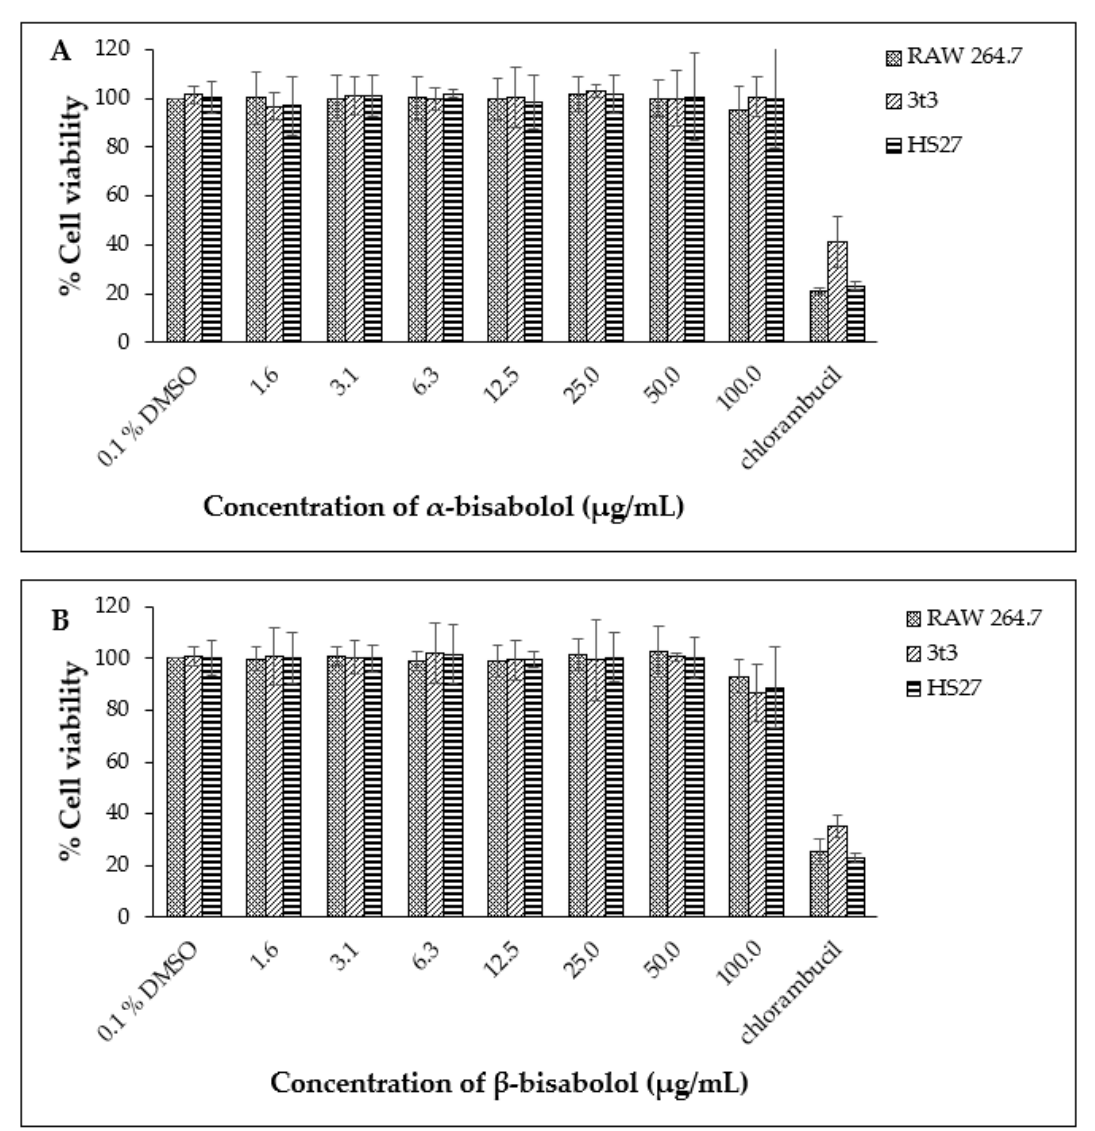
Figure 2. Cell viability observed for RAW 264.7, 3t3 and HS27 cells ( n = 3) exposed to α -bisabolol ( A ) and β -bisabolol ( B ) concentrations for 24 h against the positive control chlorambucil (1 mg/mL). Percentage cell viability is represented as mean ±SD.